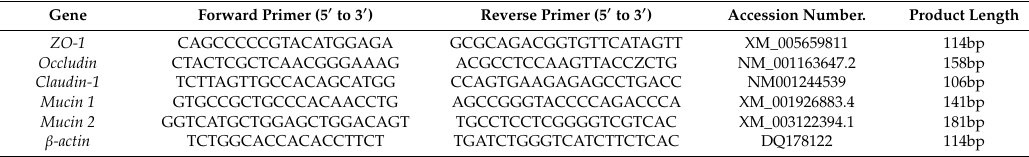
Table 3. Primers used for quantitative RT-PCR of mucosal barrier